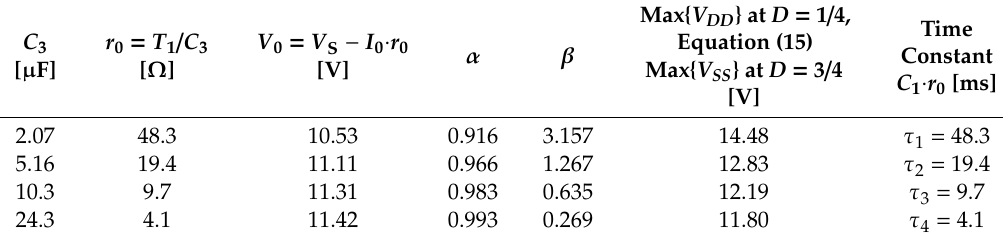
Table 1. Characteristic quantities r 0 , V 0 , α , β , and extreme values for V DD and V SS .